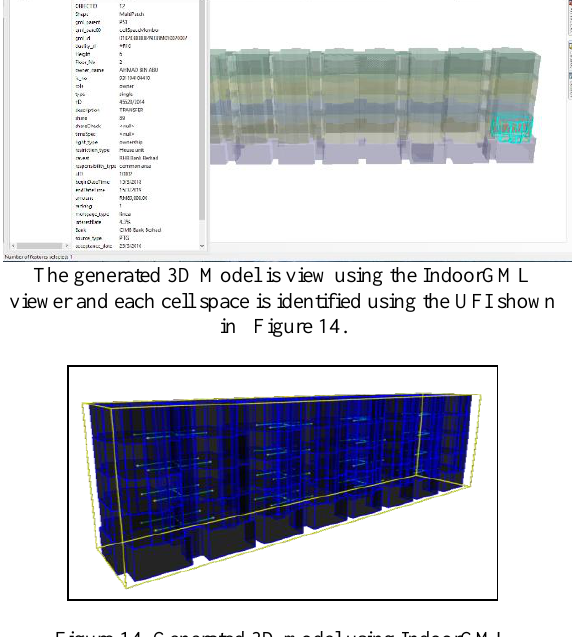
Figure 14. Generated 3D model using IndoorGML